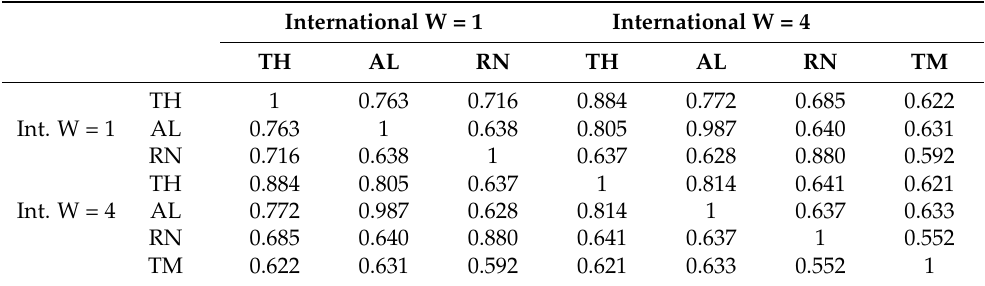
Table 5. Rank correlations between all teams’ aggregated rankings computed by different methods and applying different weights for international